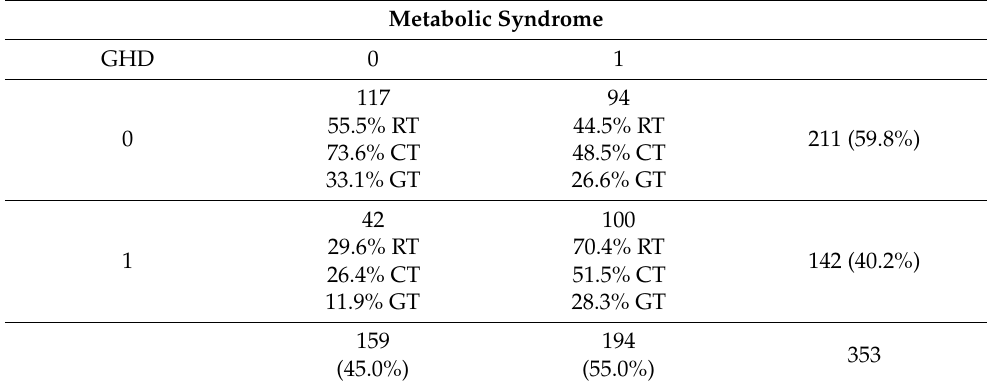
Table 5. Linear correlations between the GH secretory capacity and metabolic parameters (adjusted for sex, age and